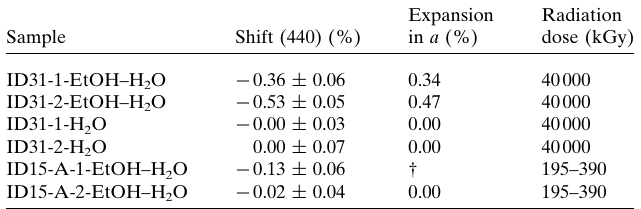
Table 1 Shifts in the (440) reflex and expansion of lattice parameter (from d-PDF fit) in comparison with estimated radiation dose for the three different types of investigated samples. Note that for PDF data no error is provided and therefore also the lattice expansion calculated from the PDF fits does not possess an uncertainty. Therefore, the error propagation of the shift from the (440) reflex is provided. See the supporting information for details on how the tabulated values were